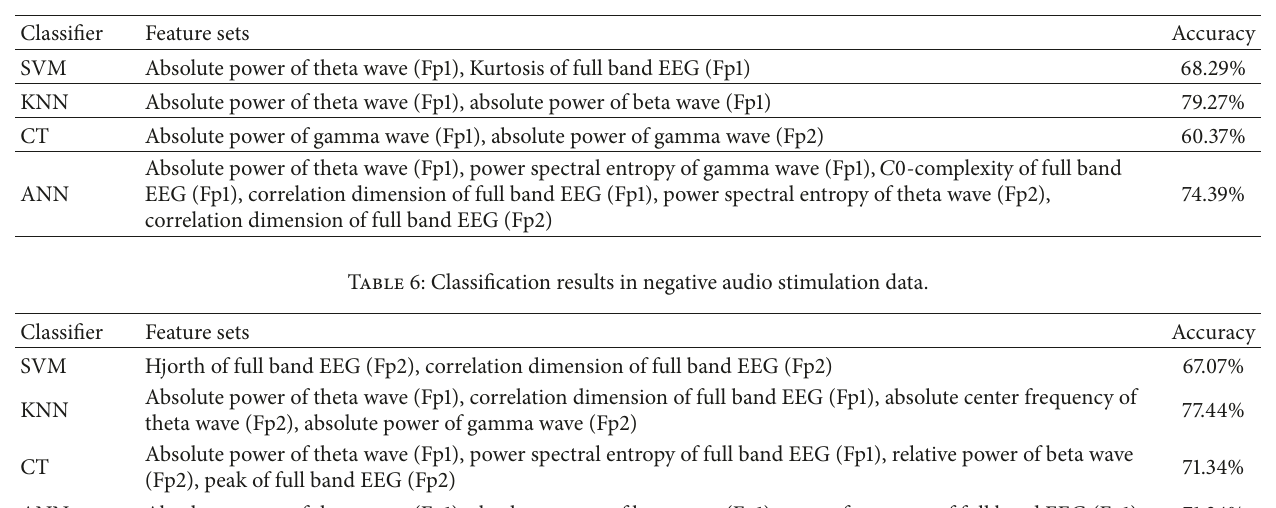
Table 5: Classification results in positive audio stimulation data.